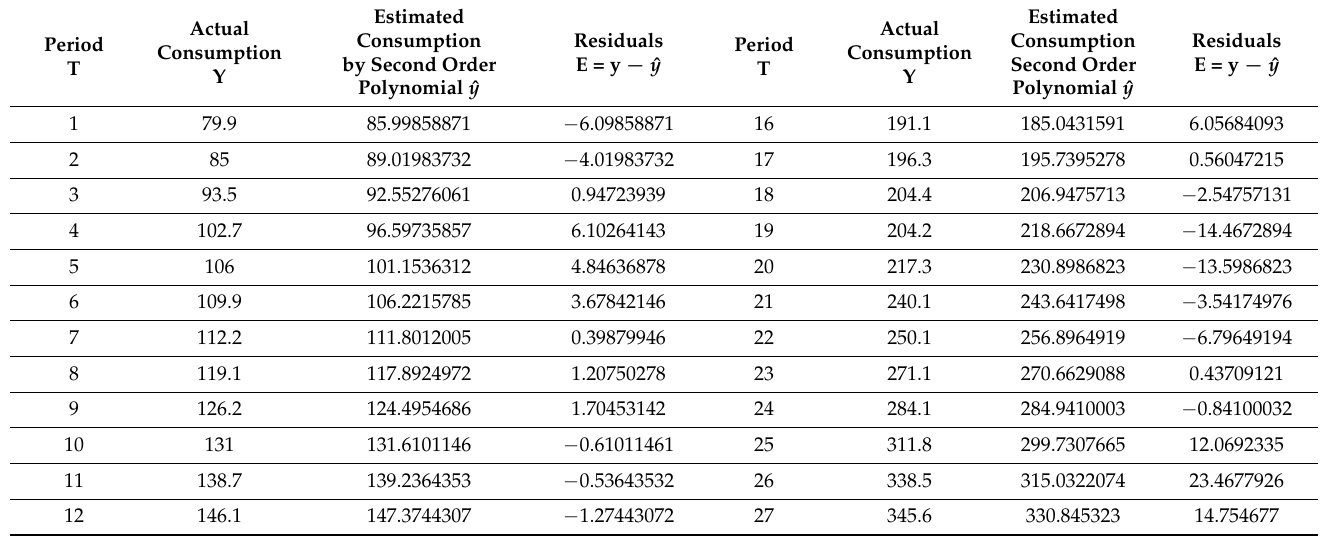
Source: Table 1, reference [3], and authors’ calculations. Table A4. Residues of the second order polynomial